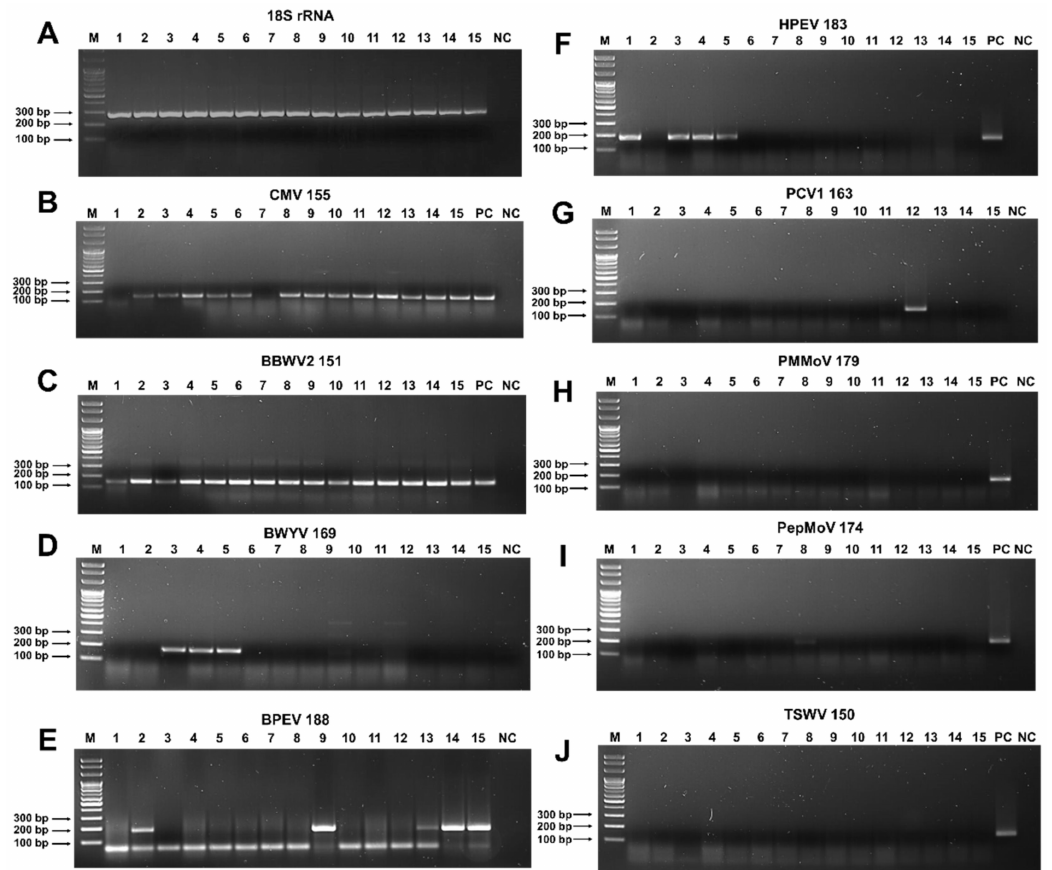
Figure 8. Detection of viruses infecting pepper plants by RT-PCR: ( A ) RT-PCR results using 18S rRNA specific primers to confirm the quality of extracted total RNAs. RT-PCR results using specific primers for CMV ( B ), BBWV2 ( C ), BWYV ( D ), BPEV ( E ), HPEV ( F ), PCV1 ( G ), PMMoV ( H ), PepMoV ( I ), and TSWV ( J ). C indicates positive control. The same total RNAs used for RNA sequencing were used for RT-PCR. The number with the virus name indicates the expected size of the RT-PCR amplicon. PC and NC indicate positive and negative controls,